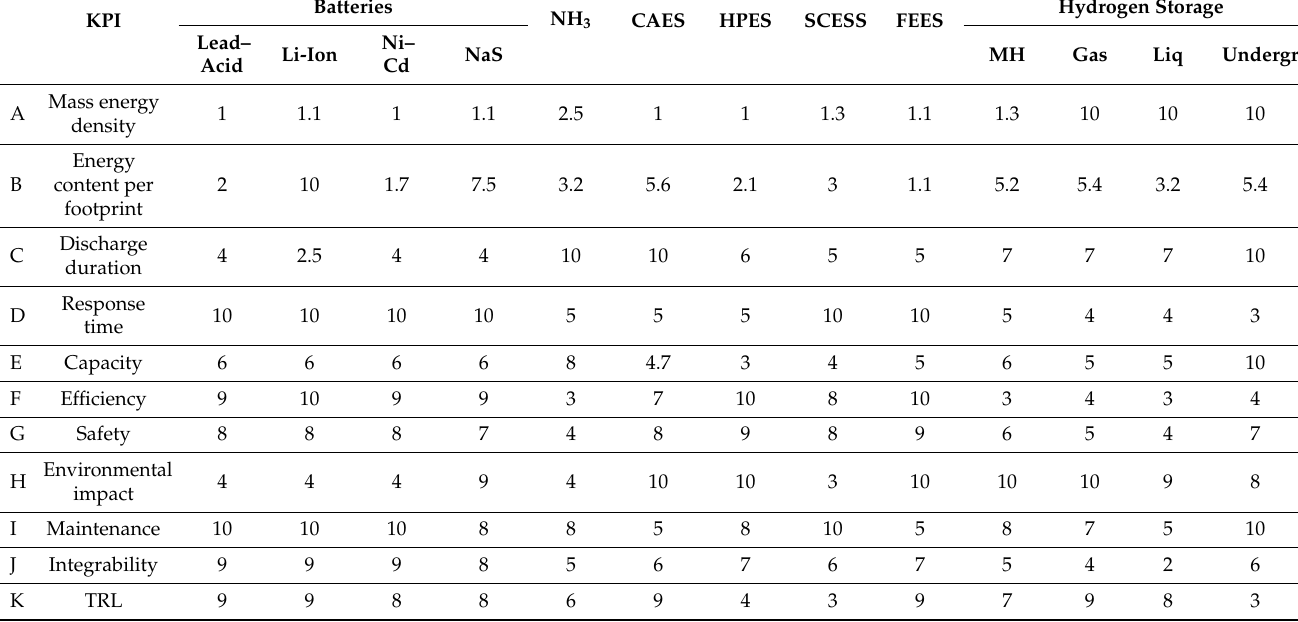
Table 5. Technology performance.